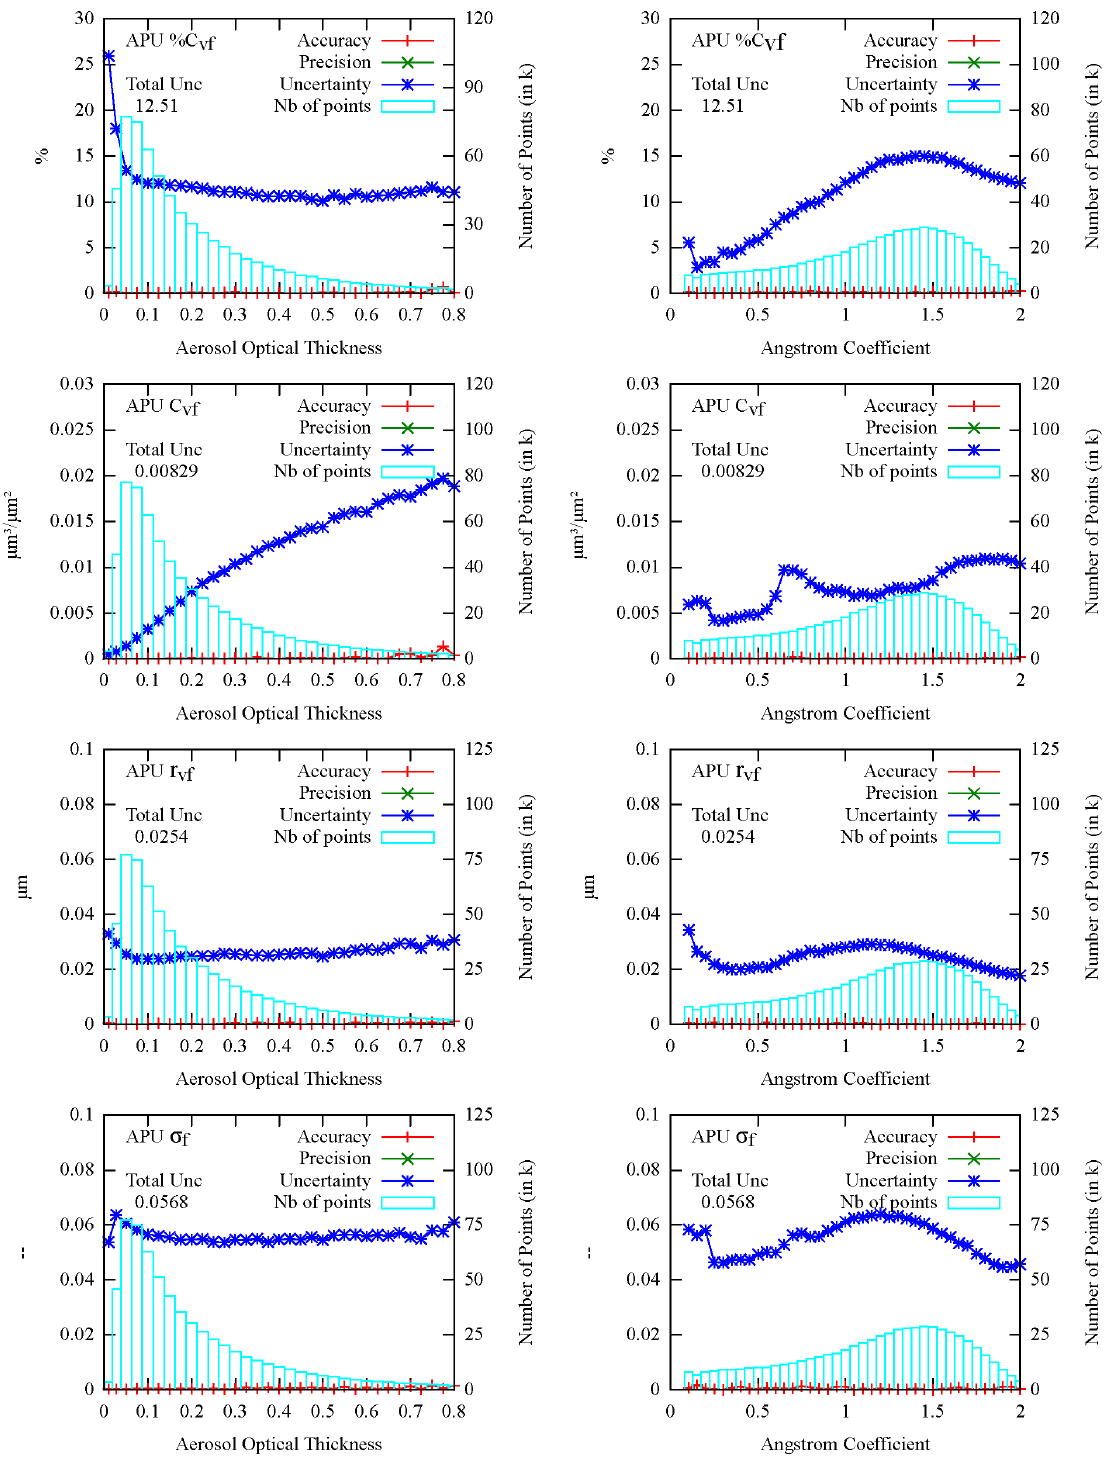
Figure A1. A , P , and U for each microphysical parameter (fine mode of the size distribution only) retrieved from a random forest approach versus the aerosol optical thickness at 440nm (left) and the Ångström coefficient between 440 and 870nm